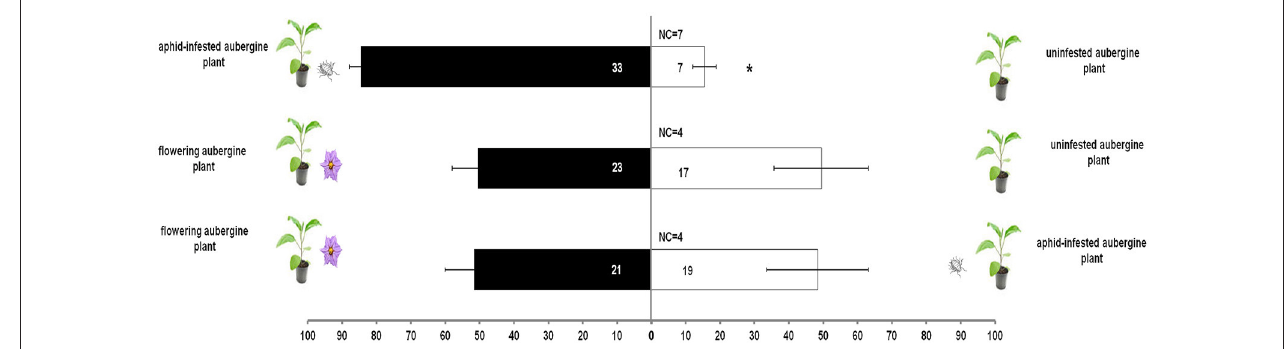
FIGURE 3 | Response of M. pygmaeus nymphs originating from aubergine plants in a Y-tube olfactometer to the odors of an aphid-infested aubergine over an uninfested aubergine, a flowering aubergine over an uninfested aubergine and a flowering aubergine over an aphid-infested aubergine plant. Number in bars represents individuals that moved toward the odor source. t test (* P < 0.05; df: 1) (NC, number of individuals that did not make a